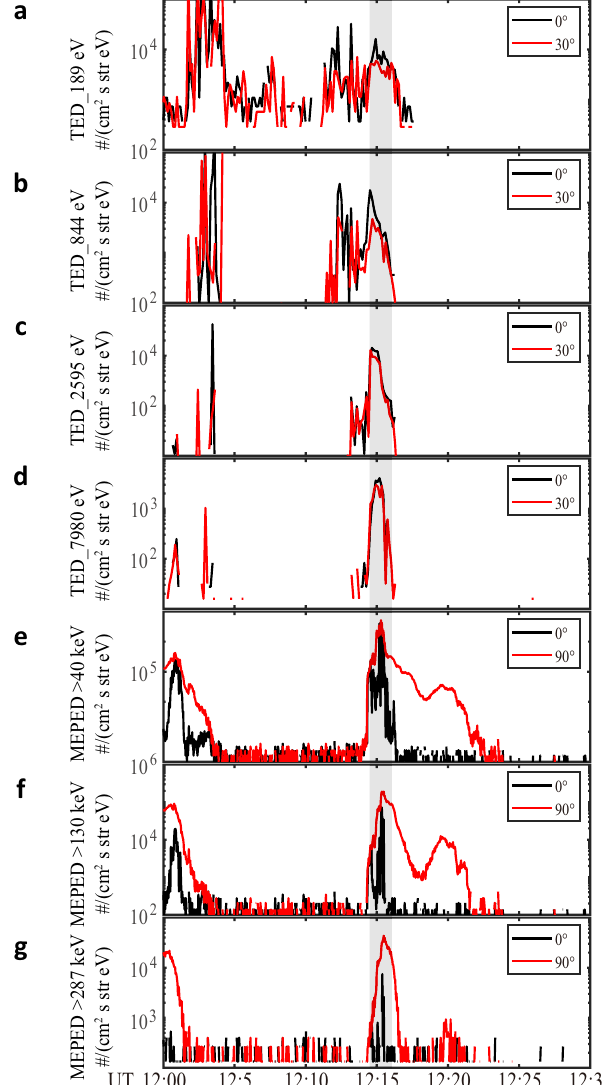
Fig. 2 | NOAA 18 observations of diffuse auroral precipitation event on 14 January 2013. a – d Precipitating electron fl uxes in different energy channels (189eV, 844eV, 2.595keV, and 7.980keV, respectively) measured by the Total Energy Detector (TED) onboard the National Oceanic and Atmospheric Adminis- tration Polar Orbiting Environmental Satellite 18 (NOAA 18) in the ionospheric position conjugated with the Van Allen Probe A. The black and red curves in a – d denote the data measured by the 0° and 30° detectors, respectively. e – g Precipitating electron fl uxes in different energy channels (>40keV, >130keV, and >287keV, respectively) measured by the Medium Energy Proton and Electron Detector (MEPED) onboard NOAA 18. The black and red curves in e – g denote the data measured by the 0° and 90° detectors, respectively. The gray rectangle indi- cates the electron diffuse auroral precipitation observed by NOAA 18 in the iono- spheric position conjugated with Van Allen Probe A, which has detected chorus waves and their second-harmonic near the magnetospheric